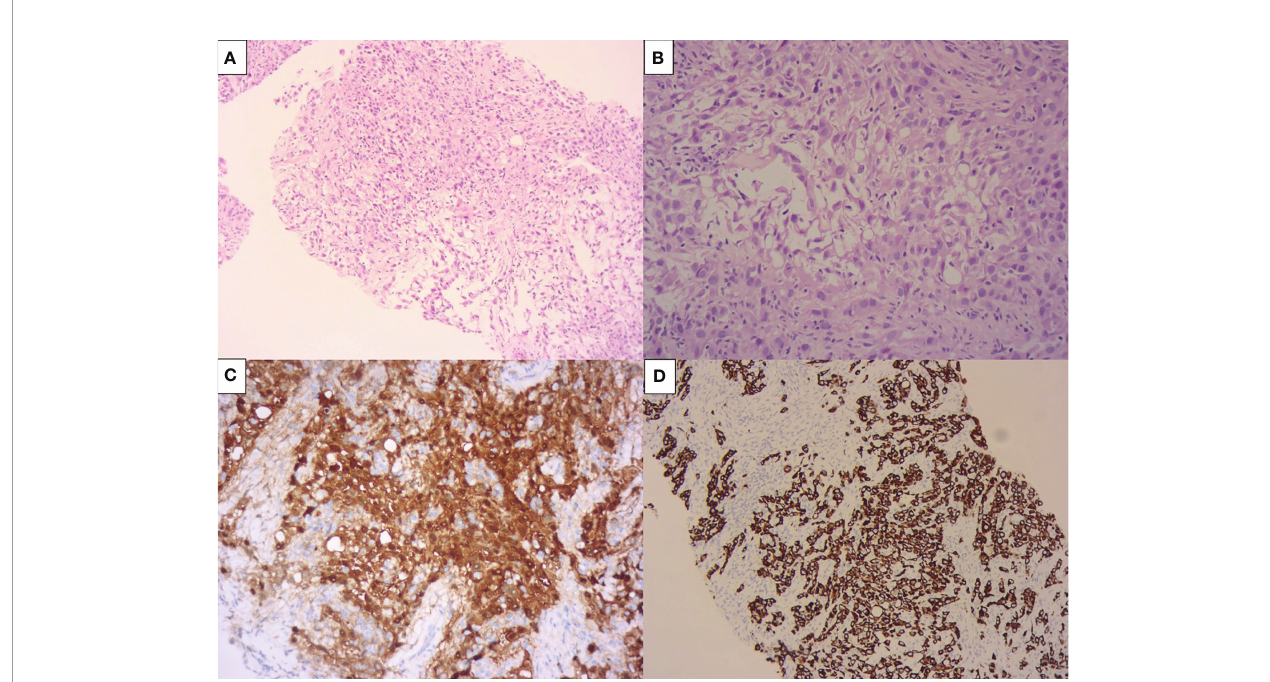
FIGURE 2 | Pre-treatment pleural biopsy compatible with epithelioid malignant pleural mesothelioma. The pictures show a pleomorphic, solid epithelioid neoplasia (A) , with pseudoglandular formations and scattered lymphocytes (B) . This neoplasia was positive por CK7 (C) and calretinin (D) and negative por